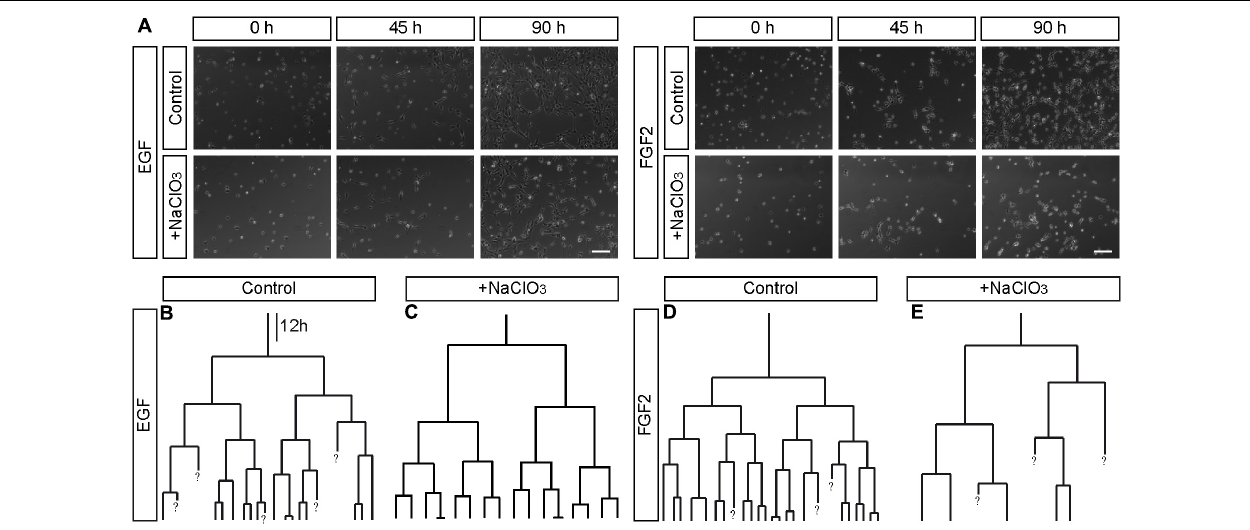
FIGURE 4 | Representative phase contrast images and lineage trees of spinal cord progenitors in vitro . (A) Phase contrast images obtained by time-lapse video microscopy at 0, 45, and 90 h of untreated (control, con) and chlorate-treated (NaClO 3 ) spinal cord progenitors exposed to EGF or FGF2. Untreated progenitors displayed higher cell densities after 90 h of cultivation than chlorate-treated cells. Additionally to the phase contrast images, exemplary movie sequences of all four conditions are included ( Supplementary Movies 1–4 ). (B–E) Representative lineage trees of control and chlorate treated progenitors tracked in the presence of EGF (B,C) or FGF2 (D,E) are shown. There were some apparent differences between untreated control cells (B,D) and those exposed to inhibition of sulfation [NaClO 3 , (C,E) ]. The cell divisions of most sibling-cells occurred in a highly synchronous way. Chlorate-treated cells in the presence of FGF2 divided asynchronously in comparison to control cells and produced strongly distorted lineage trees. A question mark “?” indicates cells which were not traceable any further. Scale bar: 100 µ m. The dataset of the control has been used in a previous study conducted in parallel (May et al.,